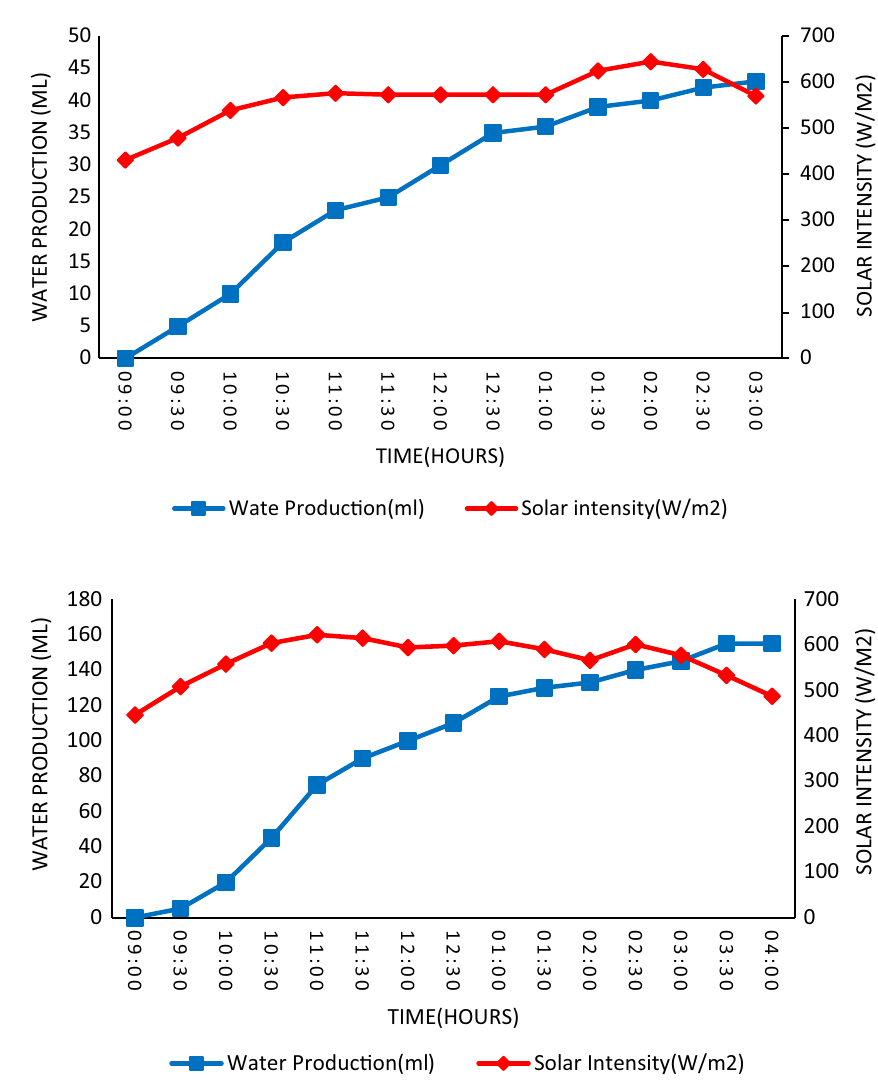
Fig. 4 Variation of water production with solar intensity w.r.t. time for molecular sieve